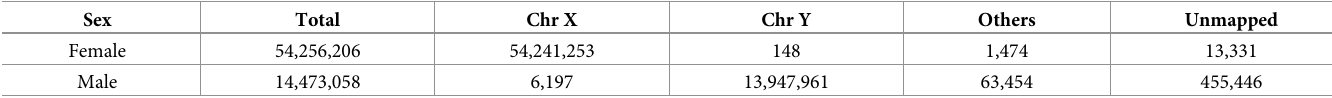
Table 3. Summary of k-mers found positively correlated with female and male samples.